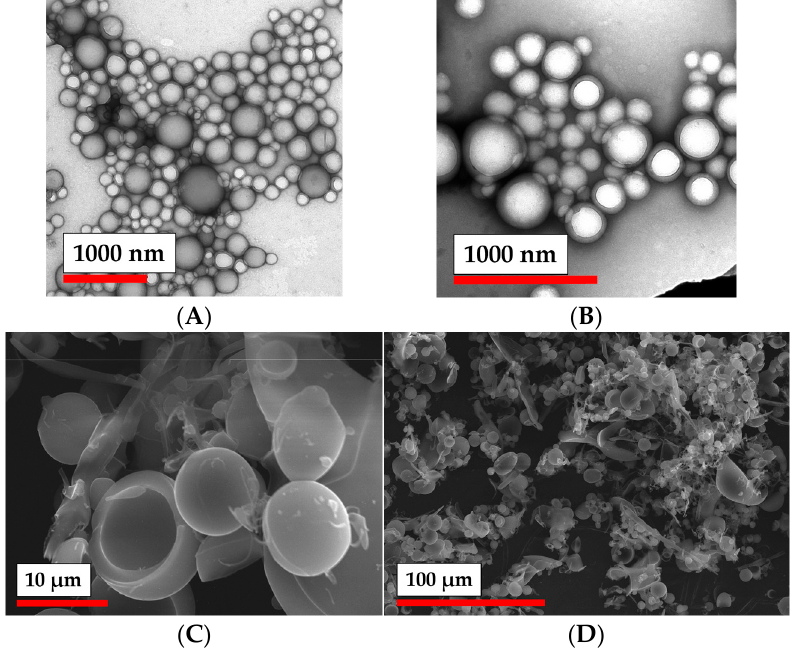
Figure 4. Morphology of PLA particles: ( A ) TEM microphotographs of initial PLA NPs; ( B ) TEM microphotographs of PLA NPs modified with AEMA; ( C , D ) SEM microphotographs of PLA NPs modified with AEMA.